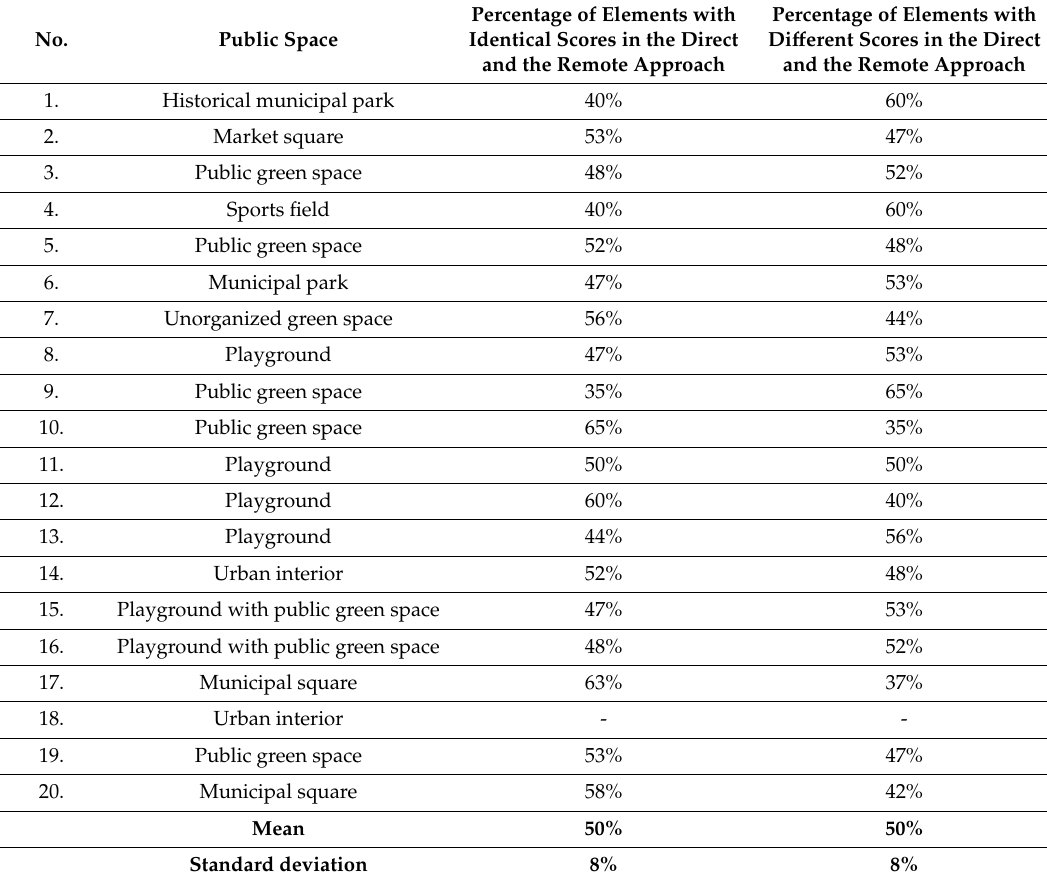
Table 5. The quality of public spaces in Mor ˛ag—similarities and di ff erences in the results generated by the direct and the remote approach. Source: own elaboration.